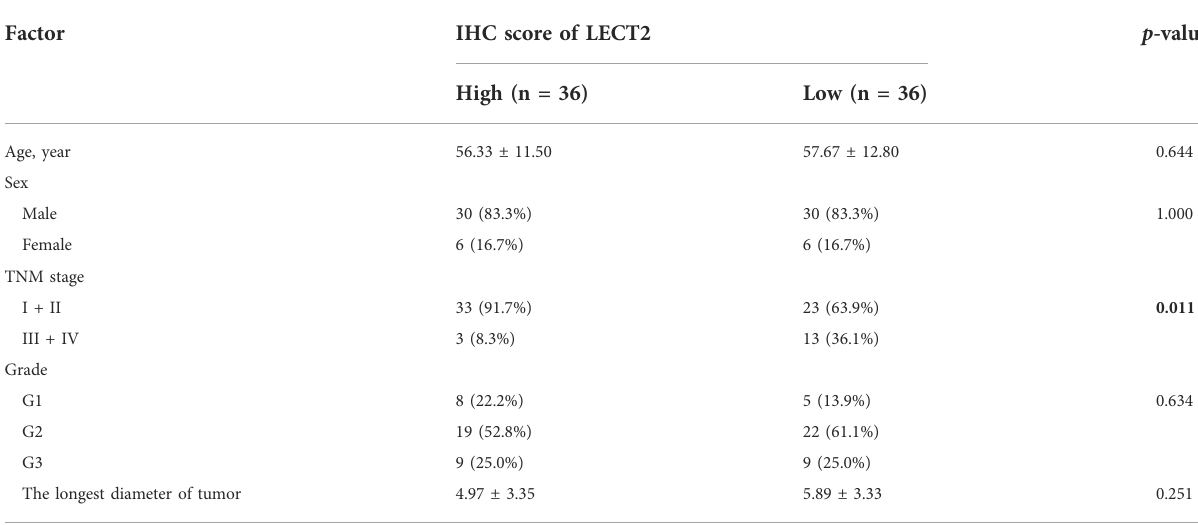
TABLE 1 Clinicopathological features of LECT2 in